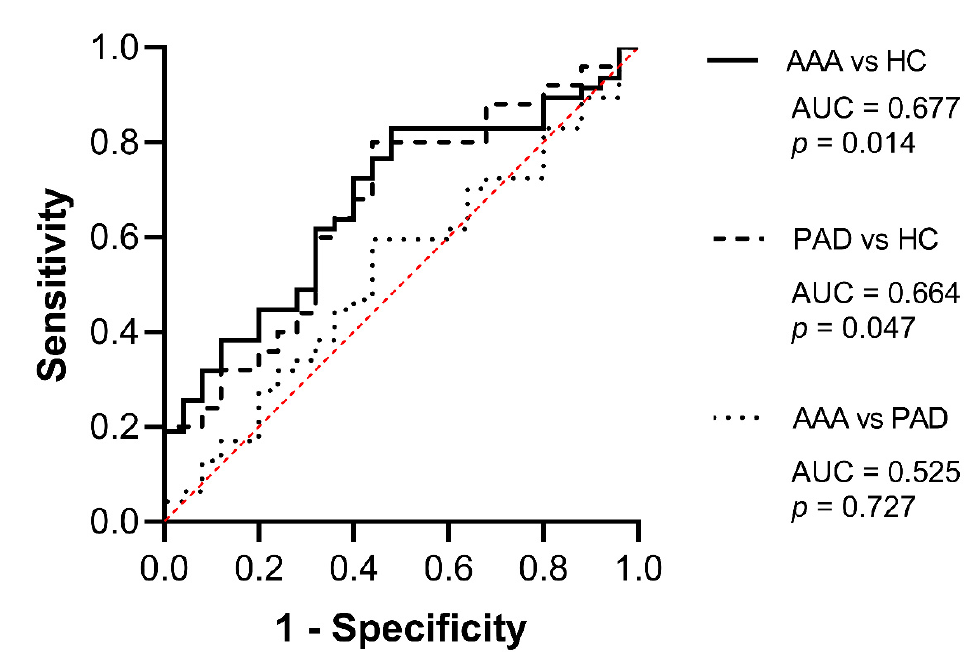
Figure 2. Diagnostic marker potential of sST2. The diagnostic marker value of sST2 was further evaluated by receiver operating characteristic (ROC) analysis and the area under the ROC curve (AUC). Abbreviations: AAA, combined AAA patient cohorts 1 and 2; HC, healthy controls, PAD, peripheral artery disease patient cohort.